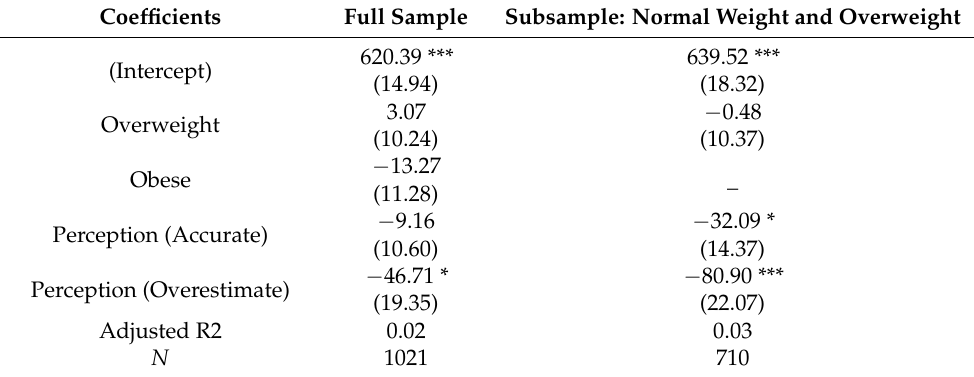
Table 5. Relationship between weight status, discrepancy between perceived and measured weight status, and calories